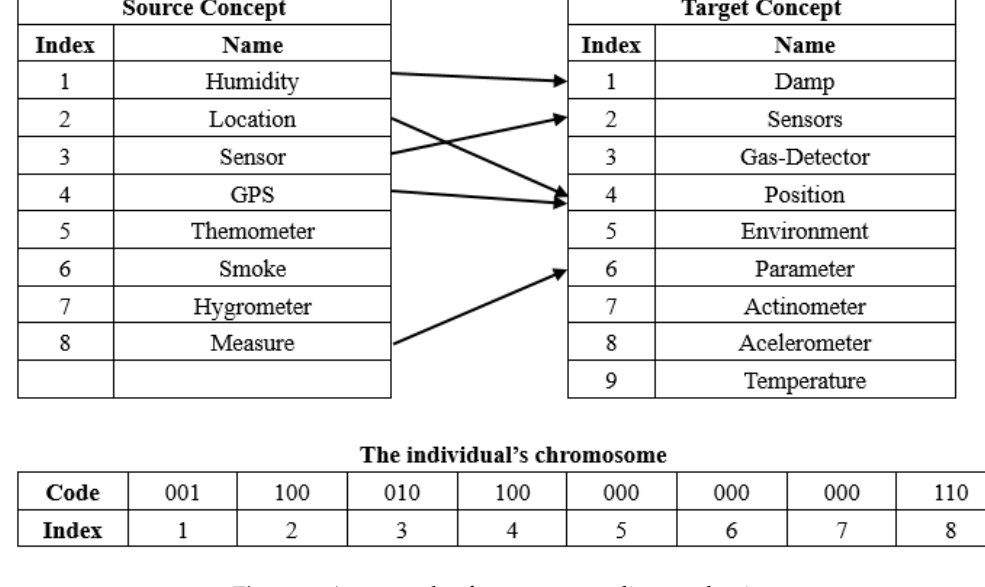
Figure 1. An example of compact encoding